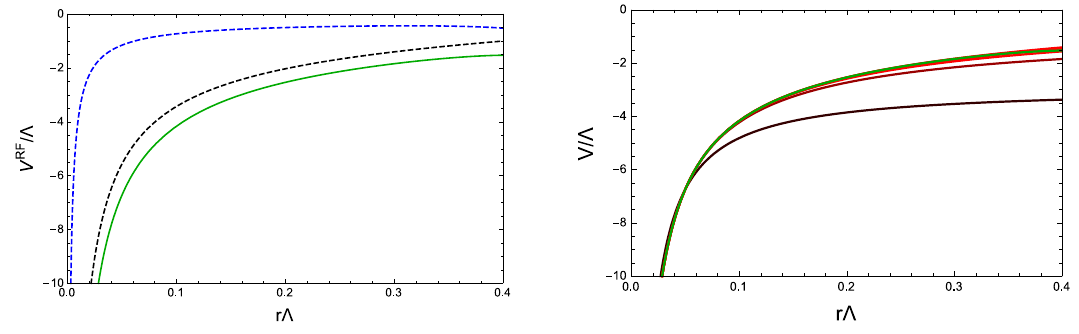
Figure 11 . Renormalon-free prediction for the static QCD potential at NLL (left). Contributions from V RF = (cid:3) (black dashed) and the (cid:14) part (blue dashed) are also shown separately. For the (cid:14) disp MS part, we use O ( (cid:11) 11 ) prediction. In the right panel, we compare it with (cid:12)xed order results at O ( (cid:11) s ), s ), O ( (cid:11) 7 ), O ( (cid:11) 9 ), and O ( (cid:11) 11 ). Deeper red line corresponds to higher order result. O ( (cid:11) 3 ), O ( (cid:11) 5 s s s s s